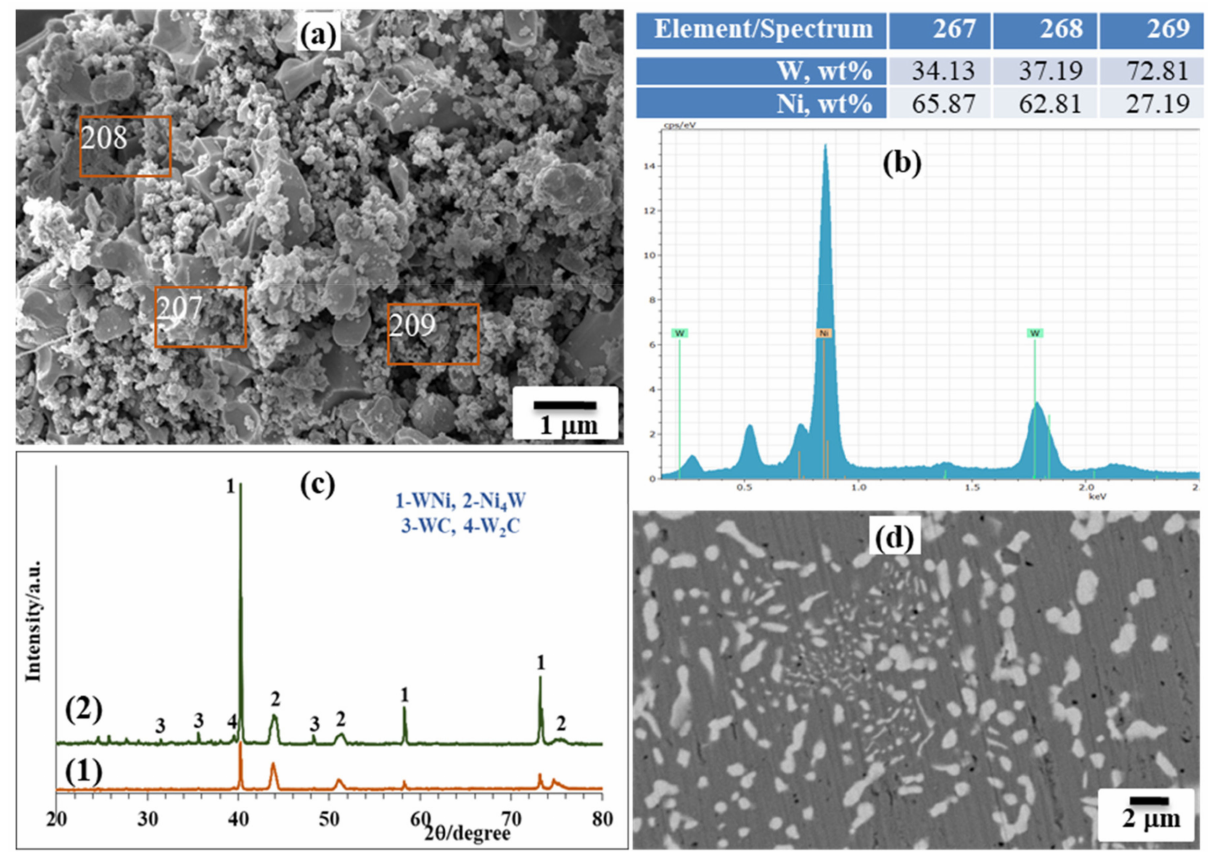
Figure 5. SEM/EDS of SHS-derived W-Ni composite powder after acid leaching ( a , b ), XRD pattern ( c ) before (1) and after SPS (2), SEM of surface of SPS-produced bulk sample, 5 min, 1200 ◦ C ( d ).